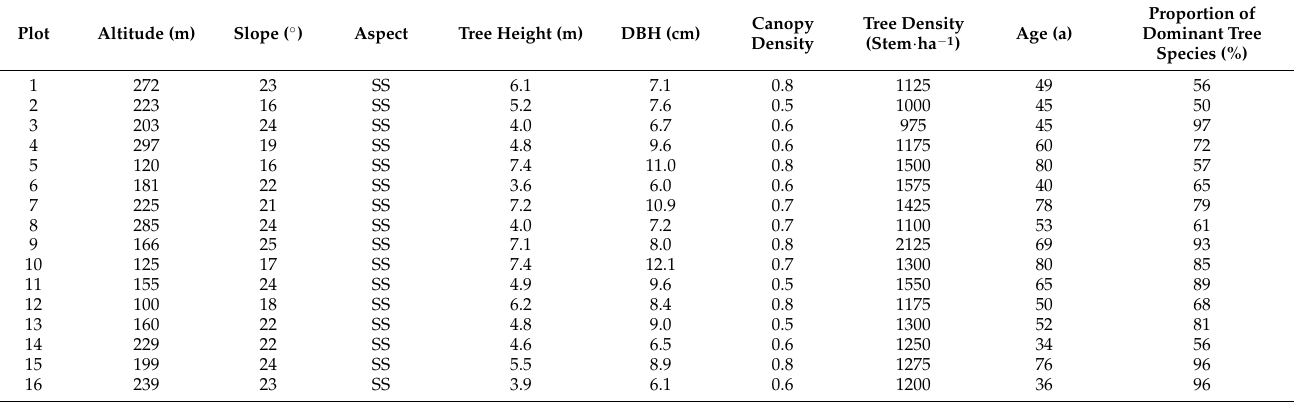
Table 1. Basic information of each sample plot.